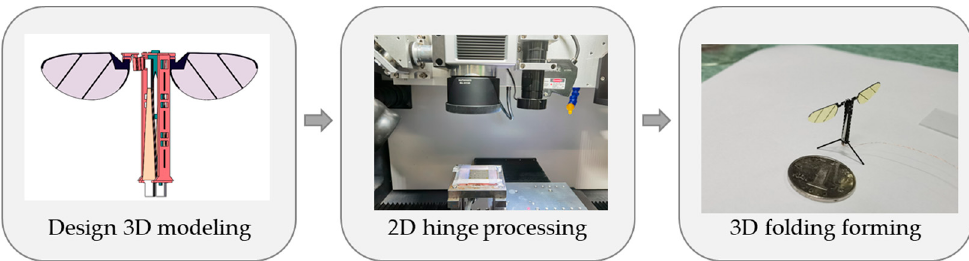
Figure 3. The whole manufacturing idea of the flapping-wing micro air vehicle.